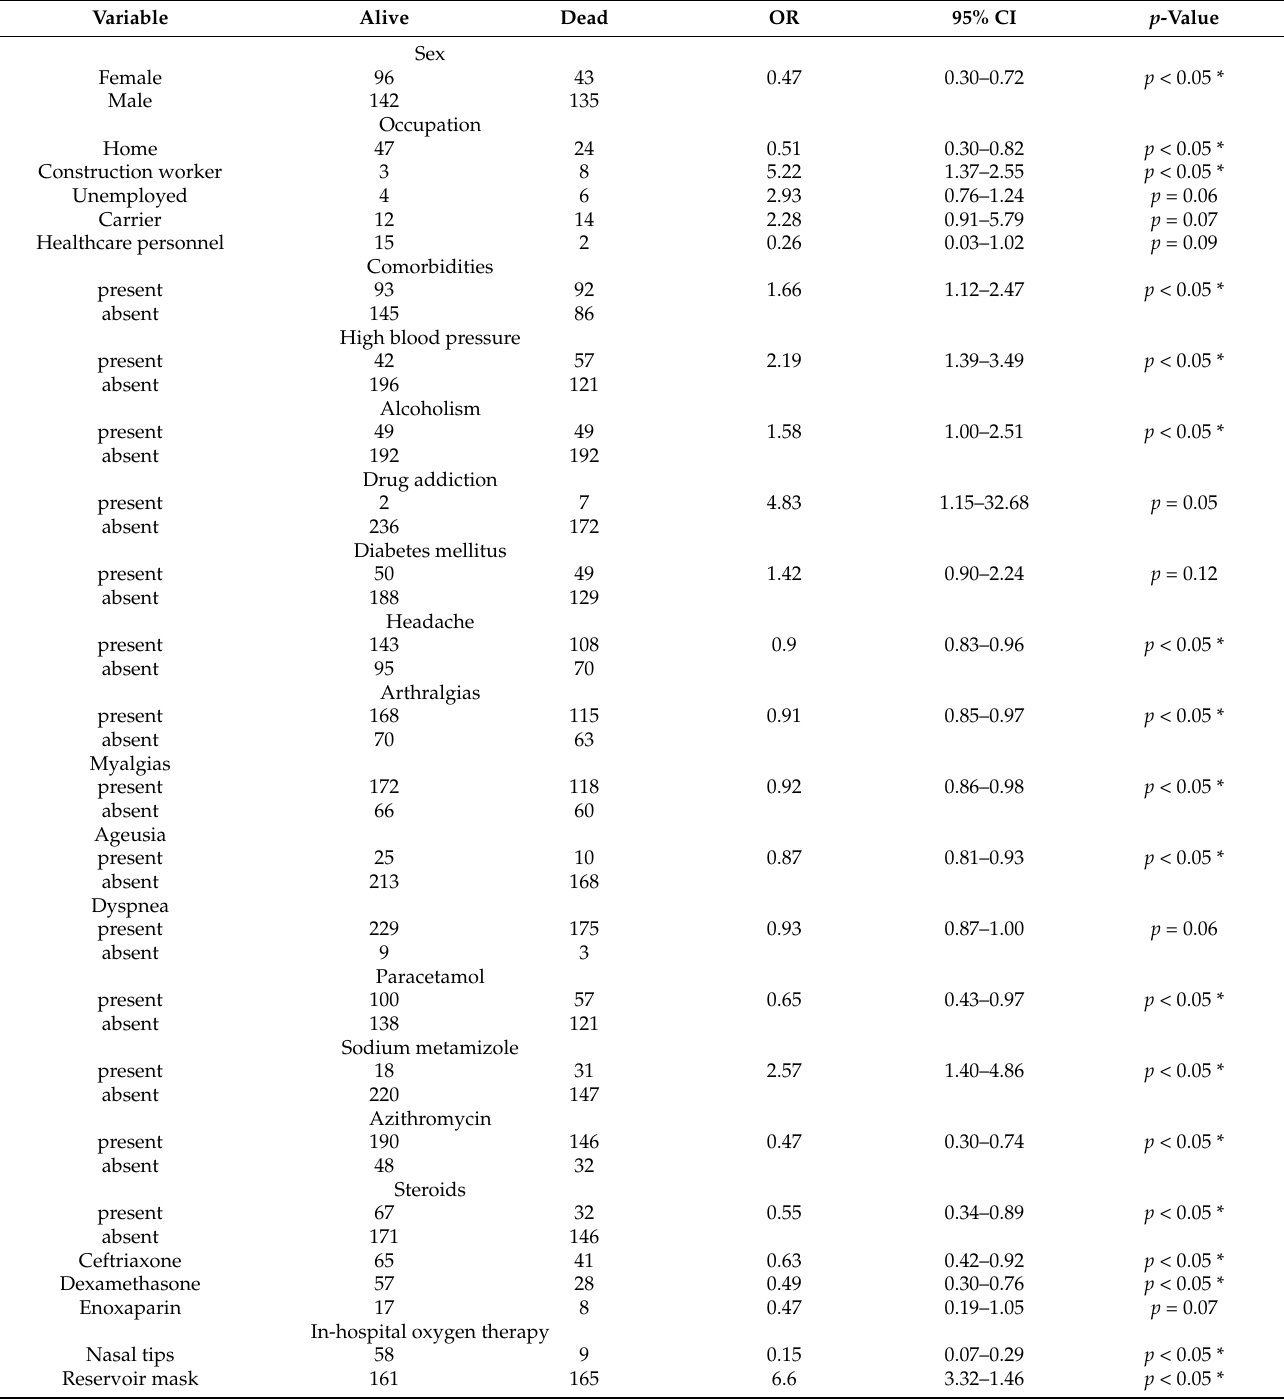
Table 1. Association between sex, occupation, comorbidities, clinical picture, drugs, and in-hospital oxygen therapy according to mortality/survival due to